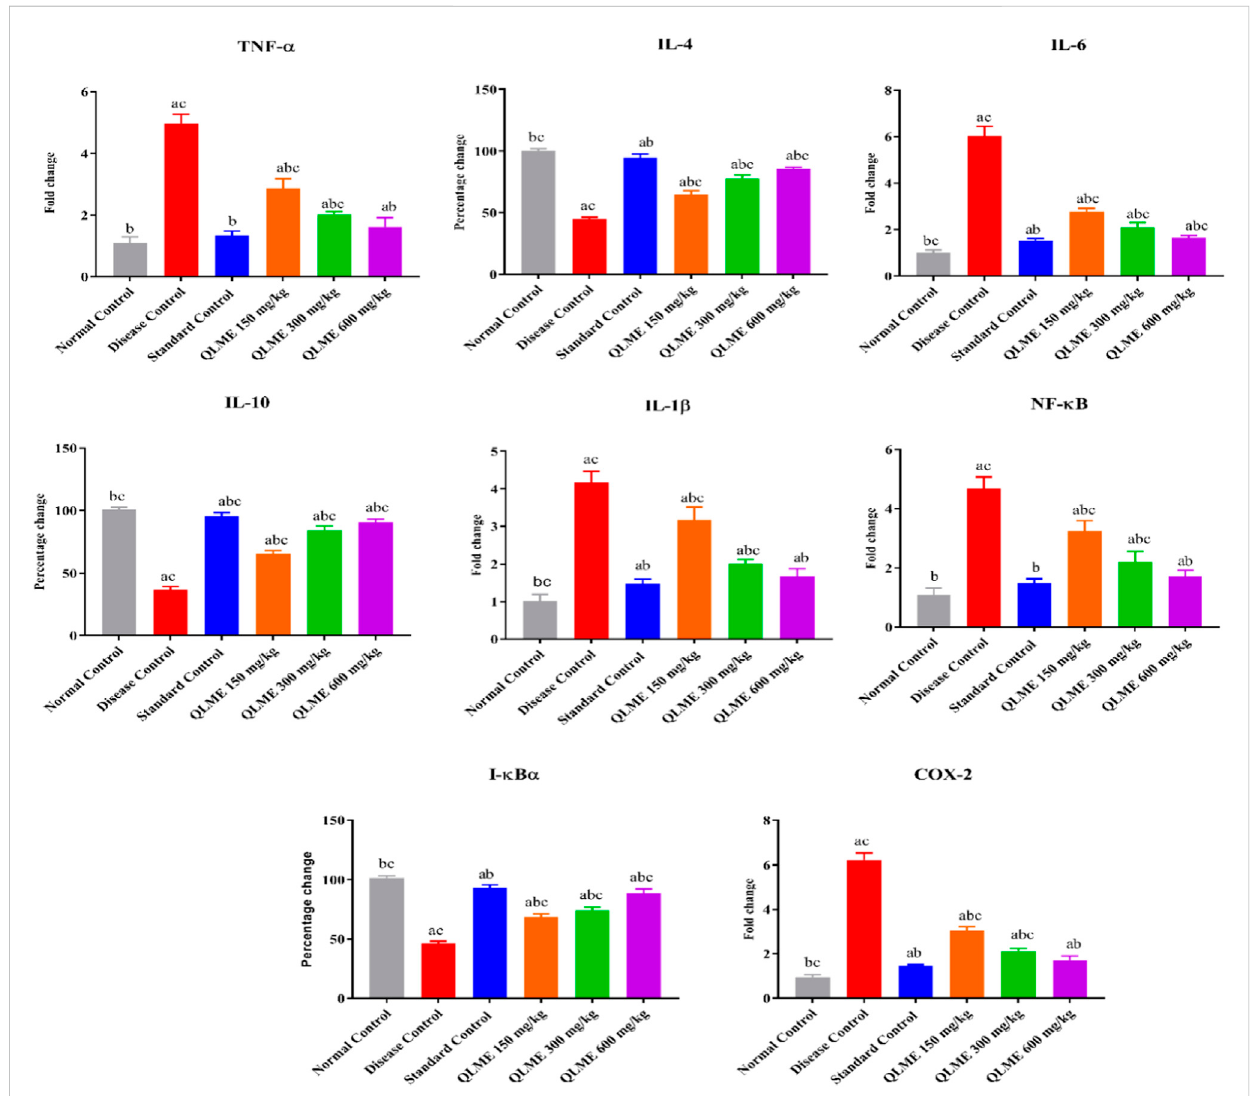
Effects of Quercus leucotrichophora extract on mRNA expression of in fl ammatory biomarkers in arthritic rats. Results are expressed as mean ± S.D (n=6)andone-wayANOVAfollowedbyTukey ’ stest.a:normalcontrol;b:diseasecontrol;andc:standardcontrol.IL:interleukin;TNF- α :tumornecrosis factor; COX-2: cyclooxygenase-2. p < 0.05 in contrast to DC, NC, and standard control